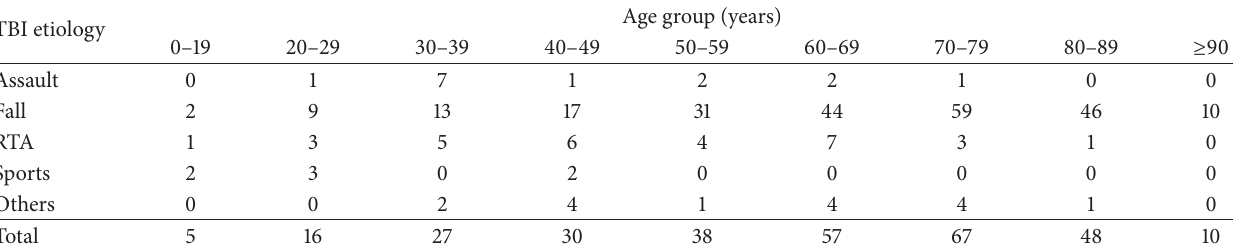
Table 2: Distribution of etiology of TBI according to age groups (years) in 298